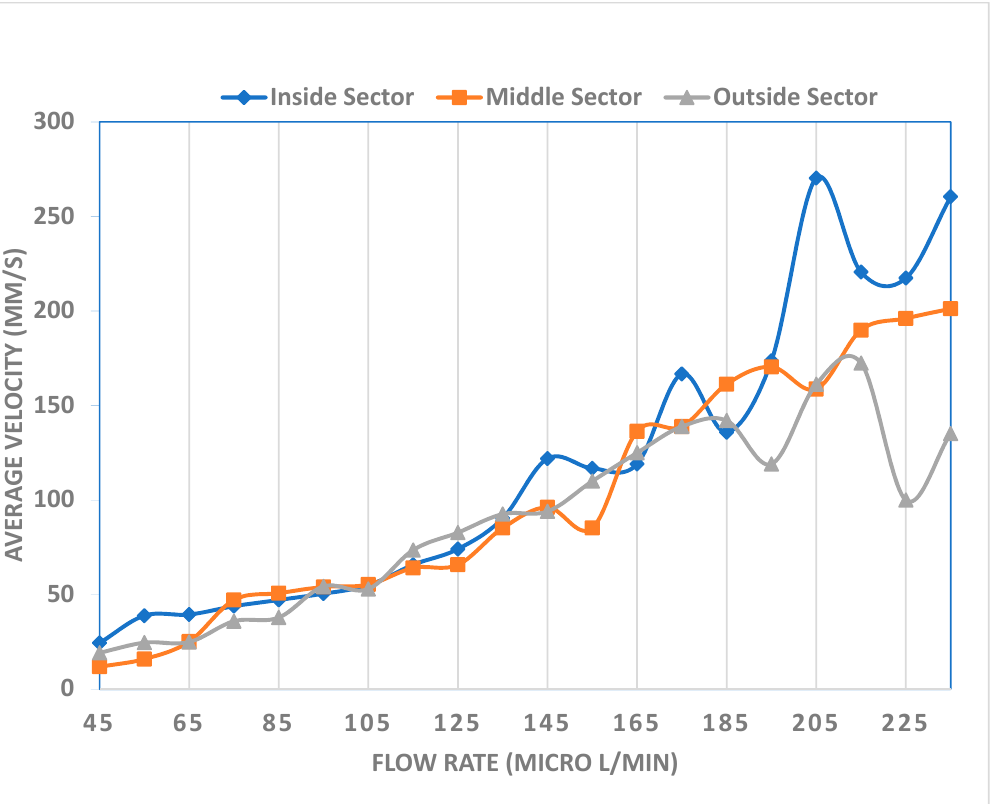
Figure 8. Gradual increase of velocity for the microsphere travelling within the microfluidic channel with respect of flow rate increase.